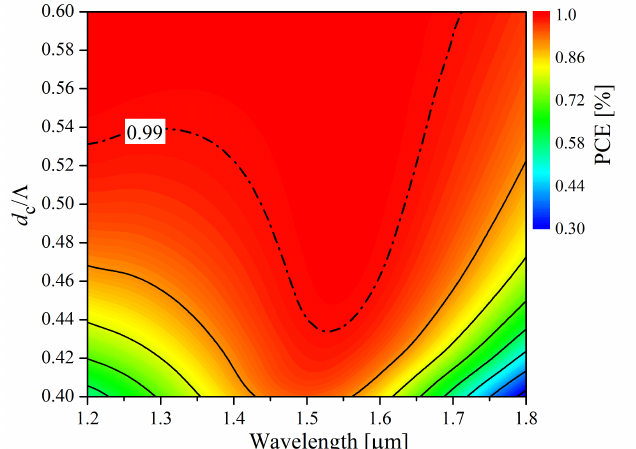
Figure 12. The wavelength dependence of the PC with different hole